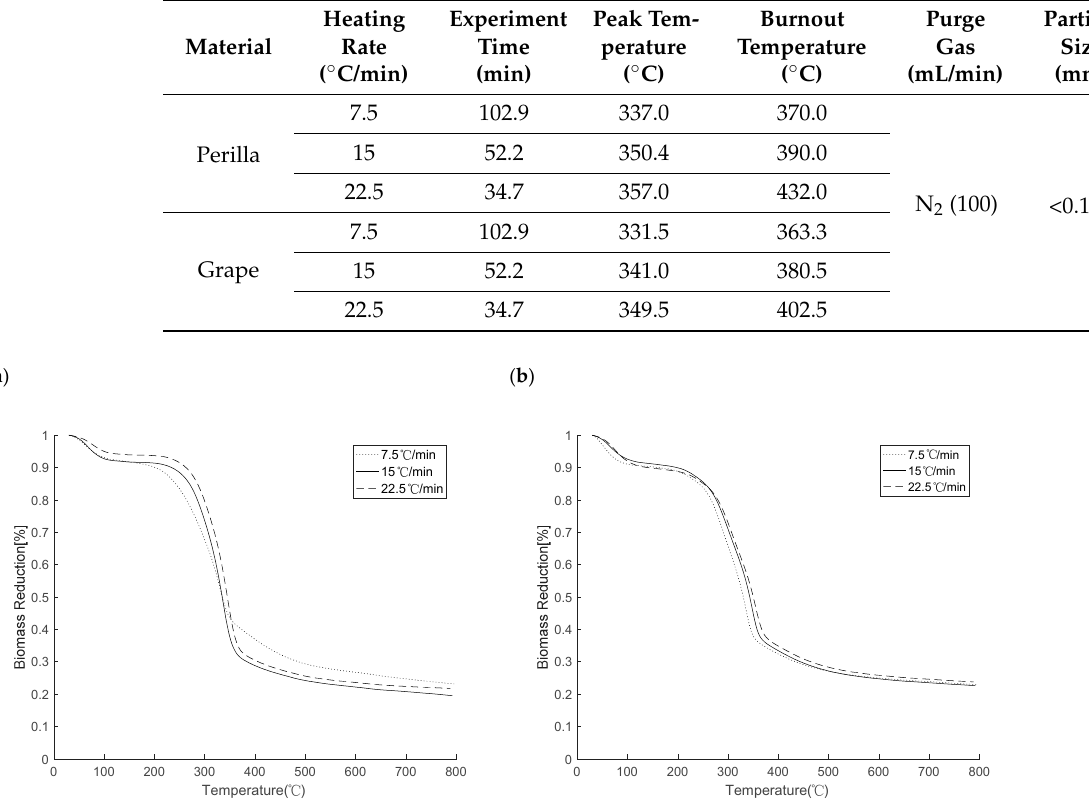
Figure 8. Biomass reduction curves for grape branch ( a ) and perilla ( b ) at various heating rates.